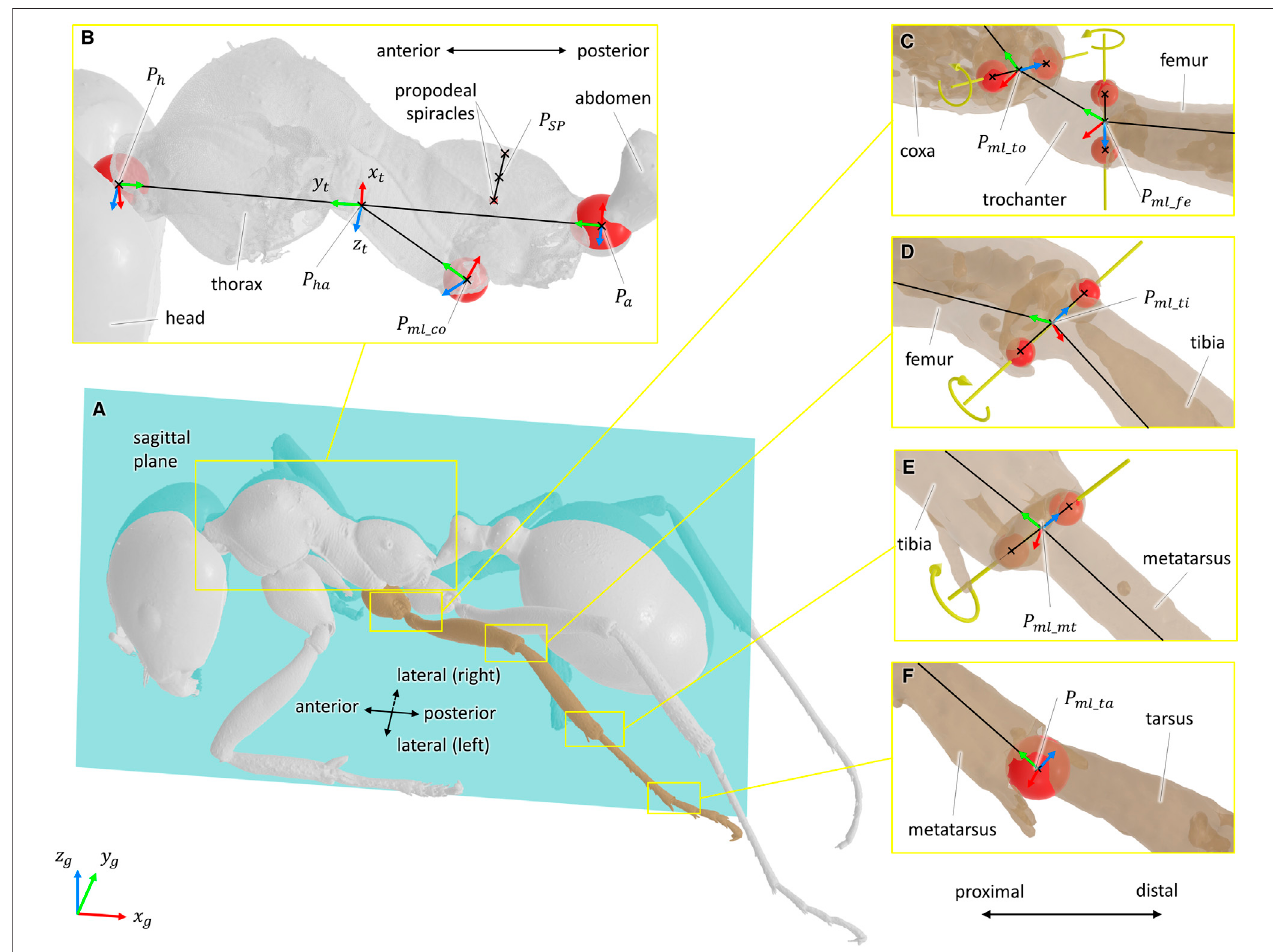
FIGURE 2 | De fi nition of the joint geometrical parameters and coordinate systems. For all coordinate systems, the x -axis is represented in red, the y -axis in green, and the z -axis in blue. For ball-and-socket joints, a sphere fi tted to the articular surface was considered as the center of the rotation of the joint. For hinge joints, the rotationaxis wasde fi ned asthe linepassing through the center oftwospheres fi tted tothe condyles ofthe joint.Fitted spheresare represented inred, and rotationaxes are represented in yellow. (A) Representation of the sagittal plane. (B) Geometrical elements used to de fi ne the sagittal plane, the coordinate system of the thorax ( x t , y t , z t ), and the coordinate system of the middle left coxa. The point P SP was de fi ned as the mid-point of the line segment passing through the center of the two propodeal spiracles. The points P h and P a correspond to the center of the spheres fi tted to the thorax/head and thorax/abdomen joints, respectively. The point P ml _ co correspondstothecenterofthesphere fi ttedtothearticularsurfaceofthemiddleleftthorax/coxajoint. (C – E) Geometricalelementsusedtode fi netherotationaxesand the coordinate systems of the coxa/trochanter, trochanter/femur, femur/tibia, and tibia/metatarsus joints. In respective order, the points P ml _ to , P ml _ fe , P fe _ ti , and P ti _ mt were de fi ned as the mid-points of the line segments representing the rotation axis of the joints. (F) Geometrical elements used the rotation center and the coordinate systems of the metatarsus/tarsus joint. The point P ml _ ta corresponds to the center of the sphere fi tted to the articular surface of the metatarsus/tarsus joint.